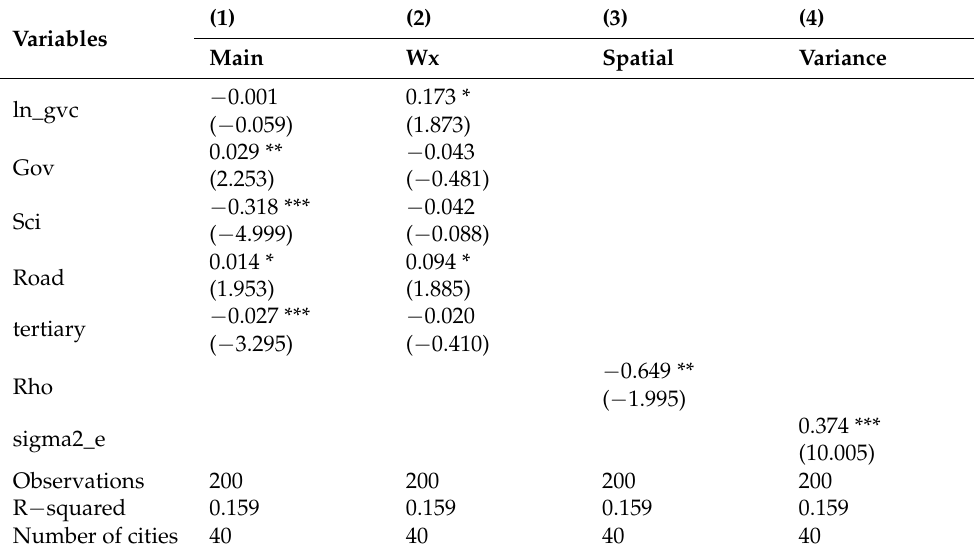
Table 11. Regression results of the ecological health